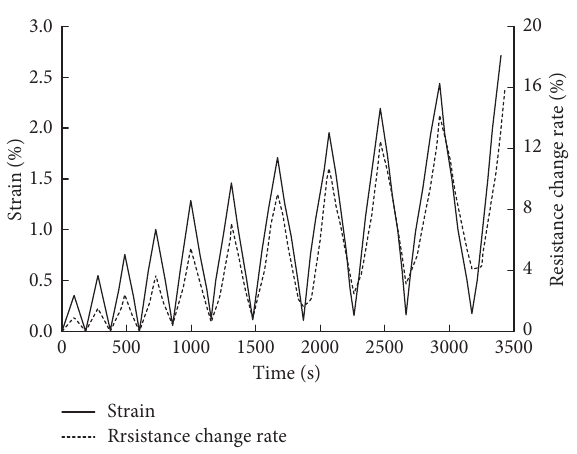
Figure 13: Curve of resistance change rate of the carbon nanotube yarn sensor and specimen